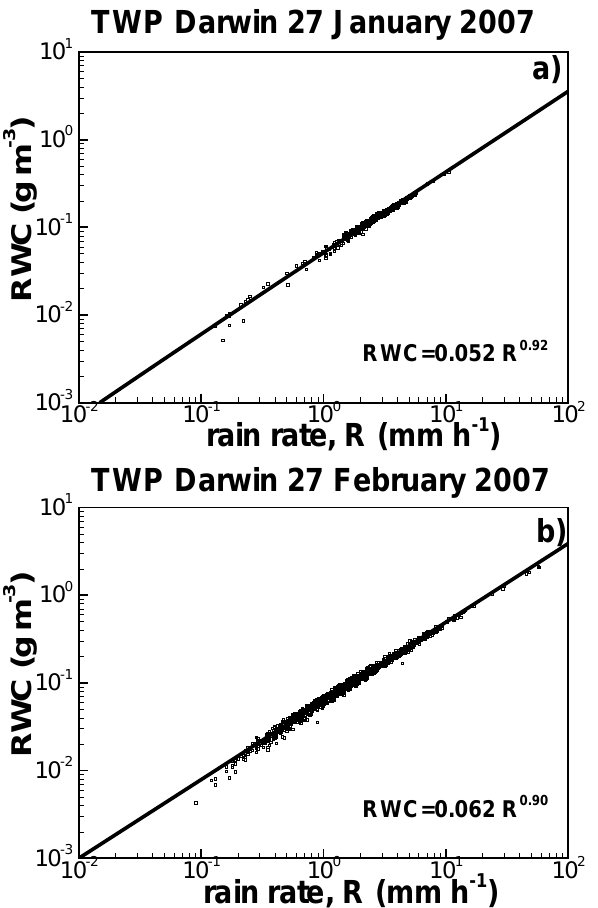
Fig. 8. Scatter plots of rain water content versus rain rate as calcu- lated from JWD DSDs for the events of 27 January 2007 (a) and 27 February 2007 (b) .